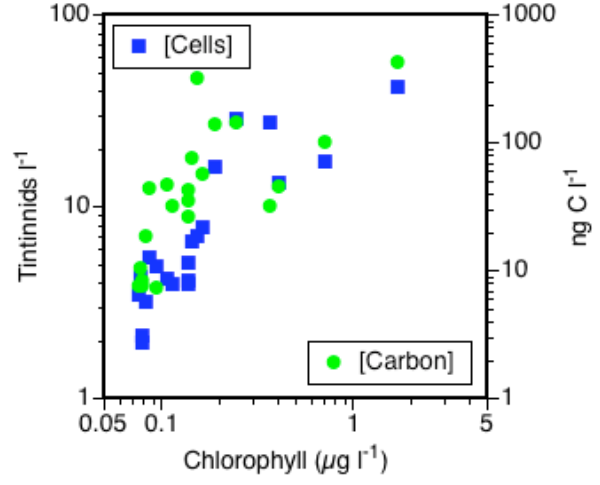
Fig. 2. Scatter plot of the relationship between phytoplankton concentration (as chlorophyll) and tintinnid ciliate abundance in terms of cells of carbon units among the stations. Data shown appears in Tables 2 and 3.